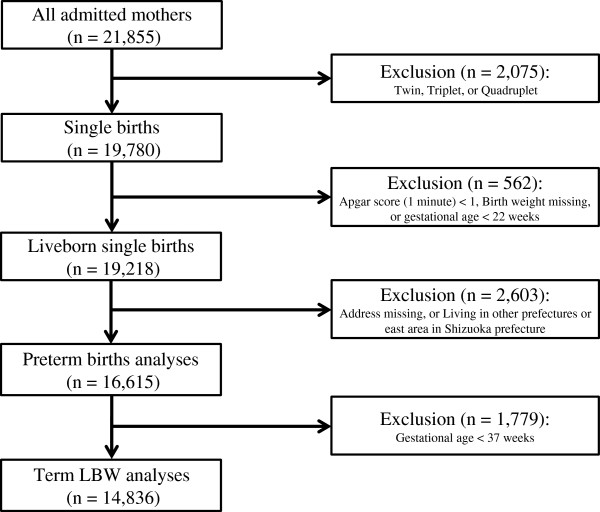
Selection of eligible births. When term low birth weight (LBW), i.e., birth weight <2500 g, was adopted as the health outcome, we restricted analyses to mothers who delivered term births (born at 37 or more completed weeks of gestation).